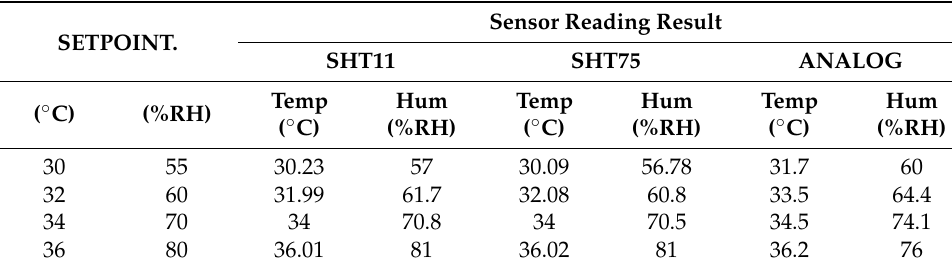
Table 2. Comparison test results of digital and analog